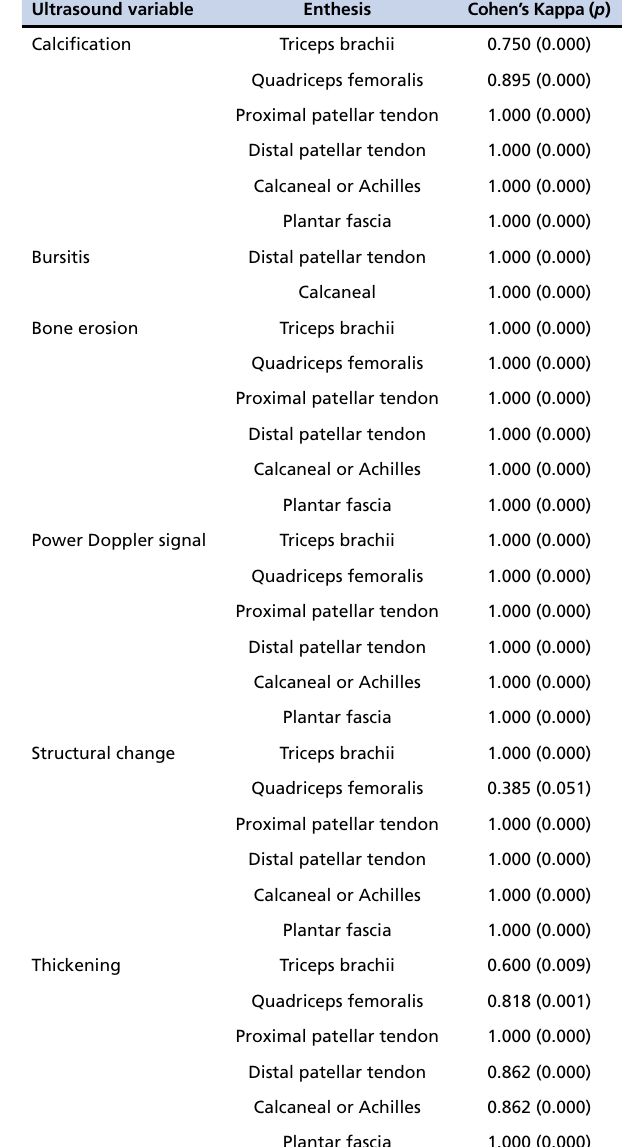
Table 4 - Concordance indices for quantitative variables (US Evaluation of Tendon Thickness) for Assessing Interobserver Agreement.